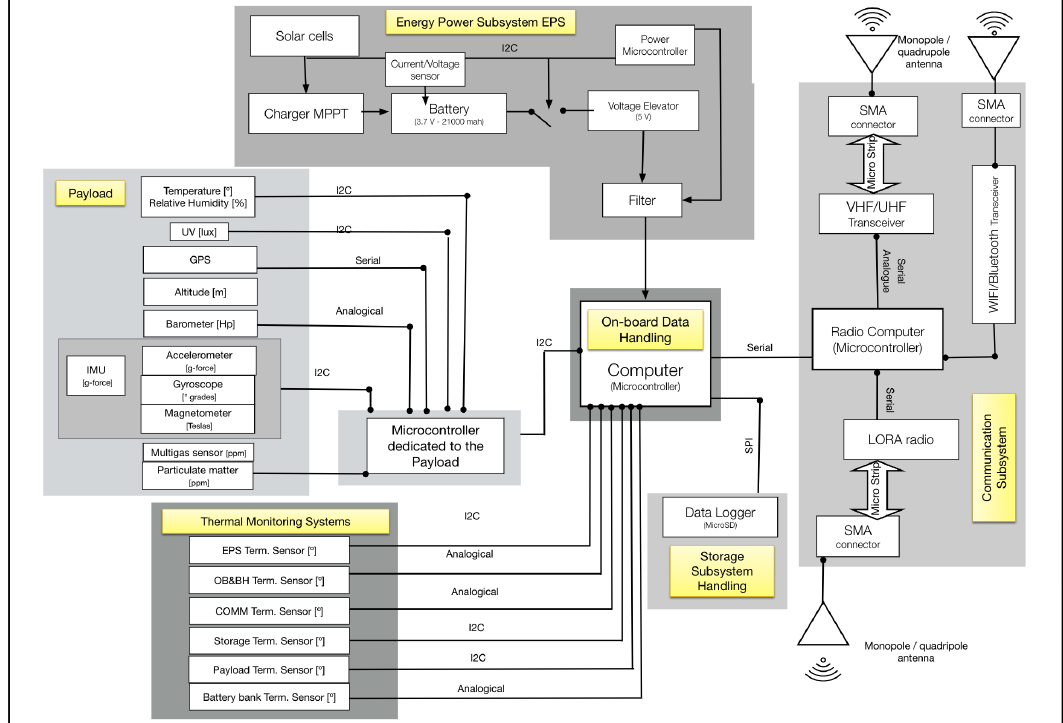
Figure 5. Flowchart with the various subsystems that comprise the Simple-4 partial centralized architecture. The Energy Power Supply (EPS) subsystem with the MPPT module controls the charge and discharge cycles of the battery and the load consumption. A dedicated microcontroller collects the payload information and, once the data is preprocessed, is delivered to the OB&DH to command the communication subsystem. The other secondary system is the thermal monitoring system, a transversal support system conformed by the different thermal sensors in each PCB